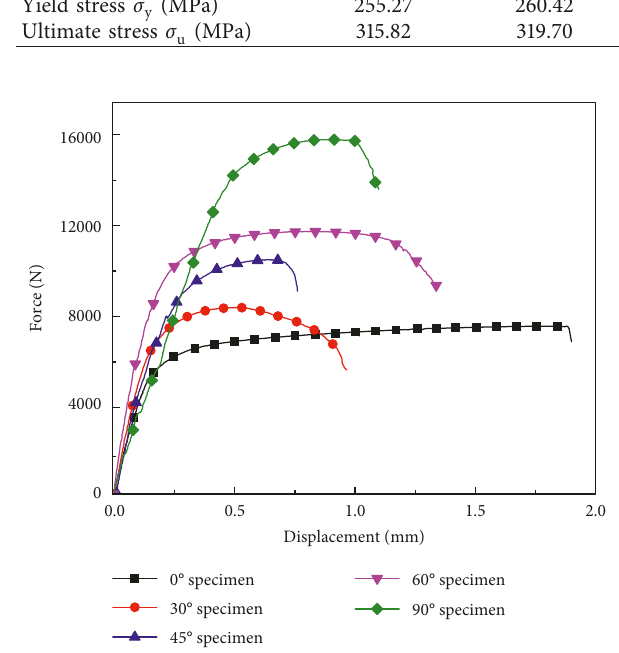
Figure 5: Experimental results for different specimens.